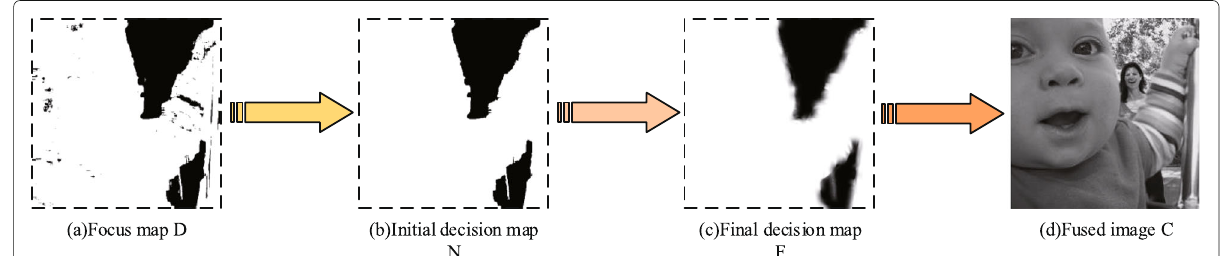
Fig. 4 Diagrammatic sketch of image fusion process. First, we utilize consistency check to remove noise area of focus map D . Then, guide image filtering is used refine the initial decision map N . Finally, the fused image C is obtained through the pixel-wise processing